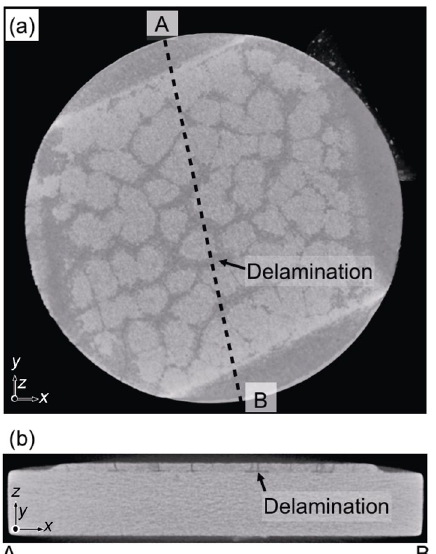
Fig. 3 (a) Transverse section of EBC system after heat exposure at 1450 ℃ for 2 h, (b) an enlarged view of Fig. 3(a).